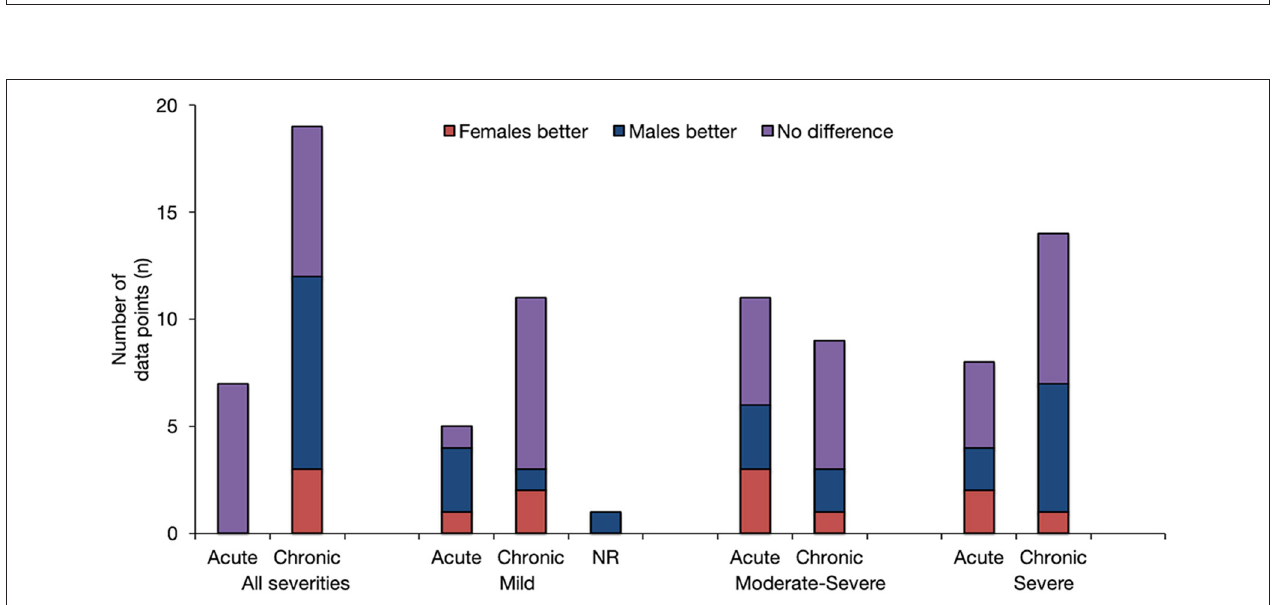
FIGURE 3 | Overview of Findings by injury severity and post-injury phase. The results are stratified according to injury severity, and whether the baseline outcome assessment was conducted prior to, at, or following the 3-month post-injury period. The height of the bar is only an indicator of assessment frequency at a certain point in